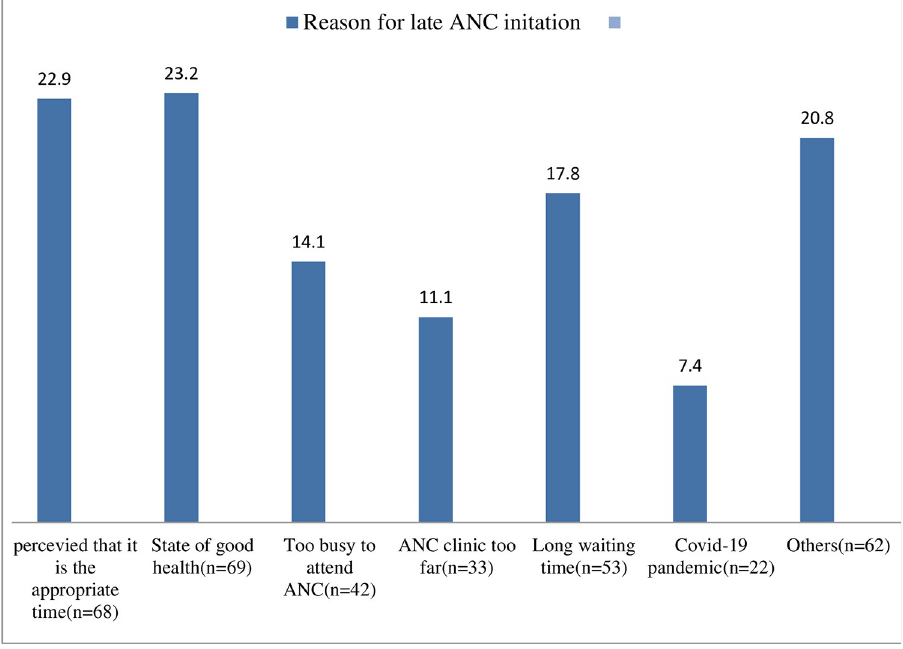
Fig 3. Reasons for late ANC attendance mentioned by the pregnant women in Mizan-Aman town, southwest, Ethiopia, 2021.